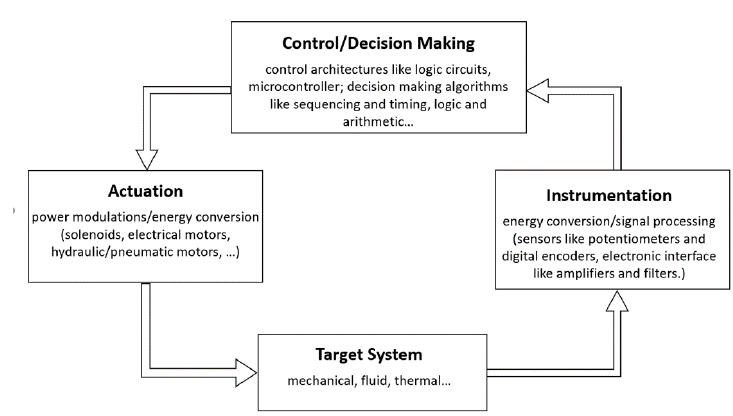
Fig. 1. Block diagram of a mechatronic